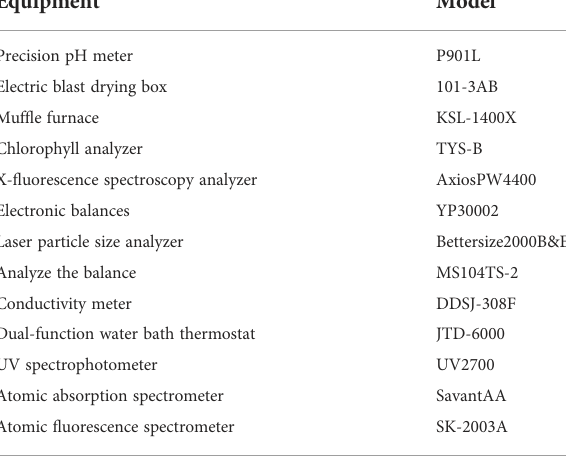
TABLE 7 Experimental equipment and device